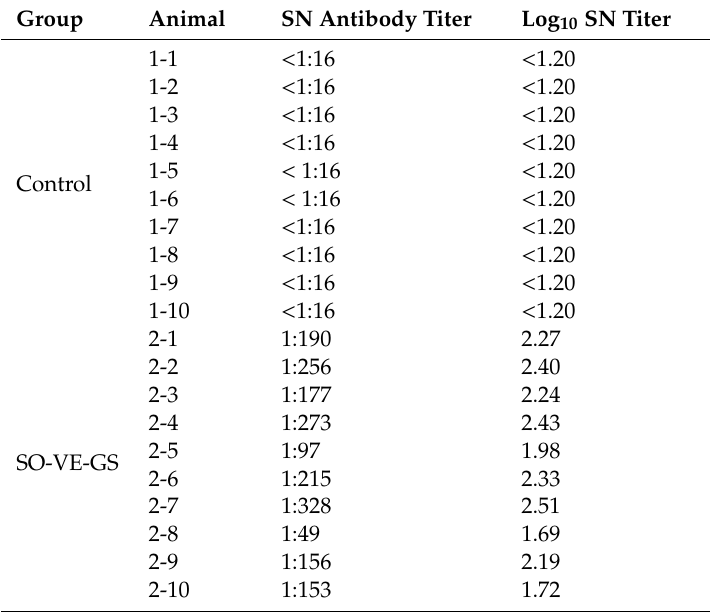
Table 1. Serum neutralizing (SN) antibody